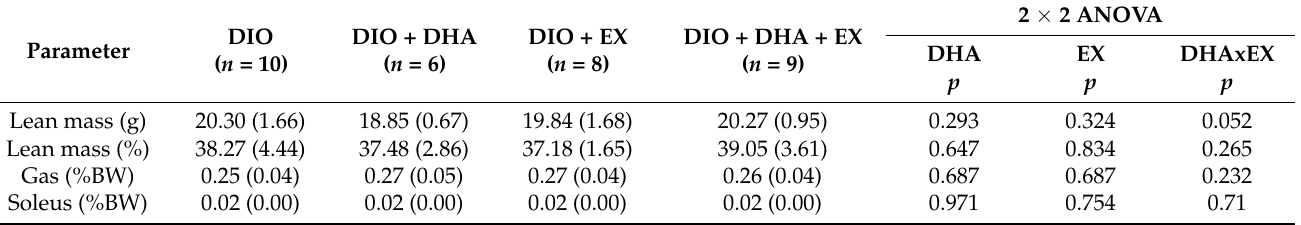
Table 3. Effects of long-term DHA supplementation and/or exercise on whole body lean mass and on gastrocnemius and soleus muscle relative mass in old DIO